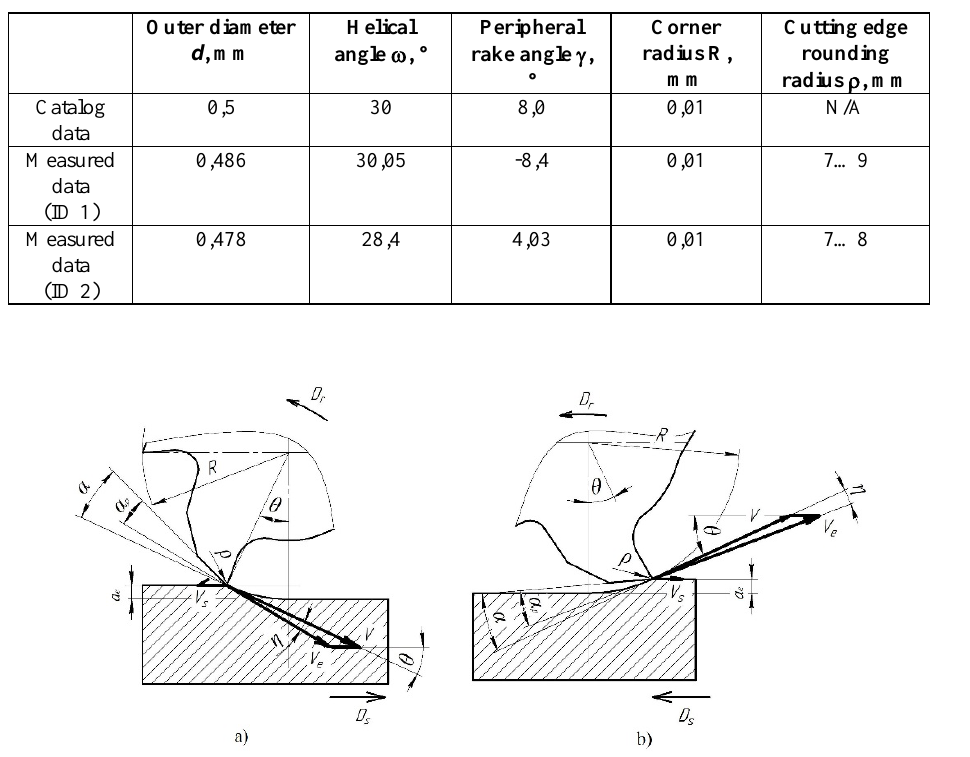
Table 1 . Designed geometry (from catalogue) compared with actual geometrical parameters of micro milling cutters